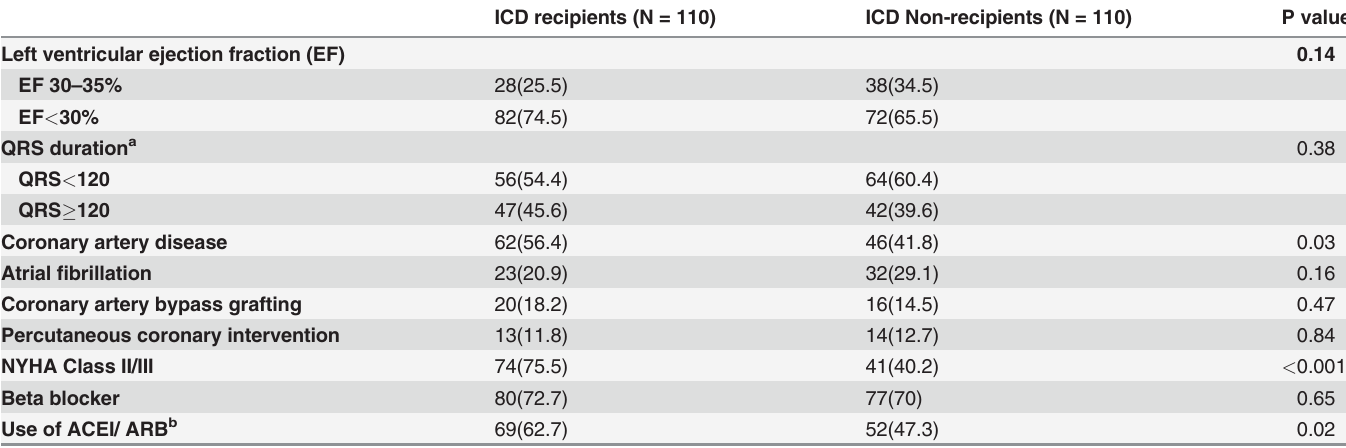
Table 2. Cardiac Parameters of ICD Recipients versus Non-Recipients.